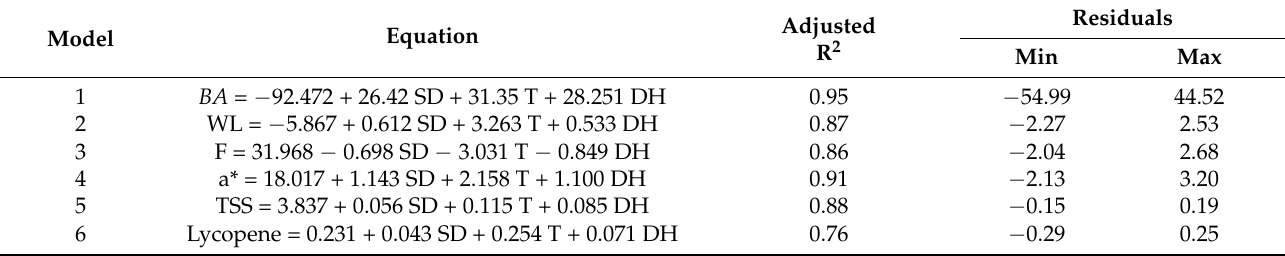
Figure 2. Bruise area of tomato impacted at different drop heights (20 cm, 40 cm, and 60 cm) for 10 days stored in 10 °C and 22 °C storage conditions. Error bars represent the standard deviation (SD) of the mean values ± S.D. of three readings of three replicates. Table 1. Linear regression equations of bruise area ( BA ), weight loss (WL), firmness (F), total soluble solids (TSS), and lycopene in relation to storage duration (SD), temperature (T), and drop height (DH) as independent